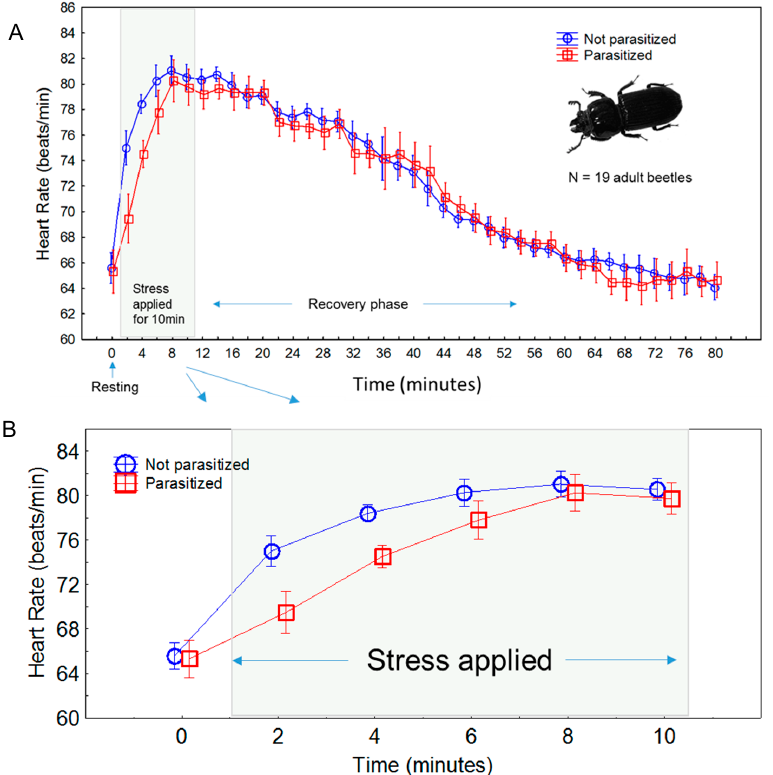
Figure 3. Results from experiment 1: ( A ) Time course of the acute stress response in 19 captive O. disjunctus specimens, based on heartrate readings, and the effects of the nematode parasite, C. passali , on the HR response. A resting, or baseline HR was obtained immediately after the beetle was removed from its housing. The restraint stress procedure followed (see Figure 2) for 10 min. Heartrate was recorded for 70 min after restraint ended to monitor recovery. Lower panel ( B ) shows an expanded view of the stress phase, where the impact of the parasite was most pronounced.